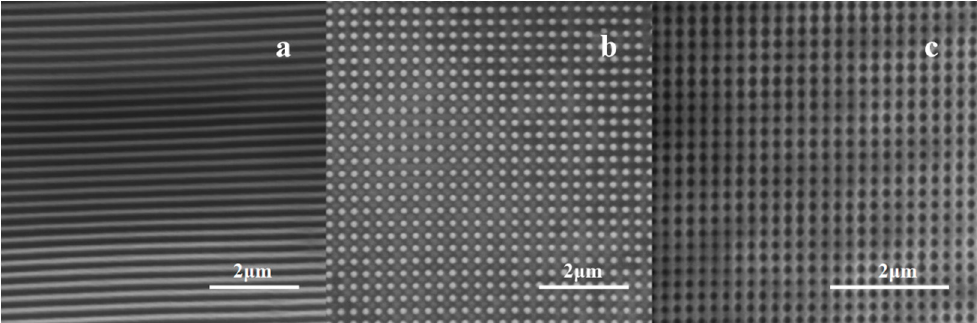
Figure 4. SEM pictures of gratings, dot, and hole arrays of the photoresist on PDMS–ITO substrate. The pictures are magnified by 40,000 times. The period of the grating ( a ) is about 273 nm. The diameter of the dot ( b ) and hole arrays ( c ) is 175 nm and 165 nm, respectively. The dot and hole arrays are made by rotating the sample holder 90° after the first exposure, and the different energy distribution leads to different nanostructures.